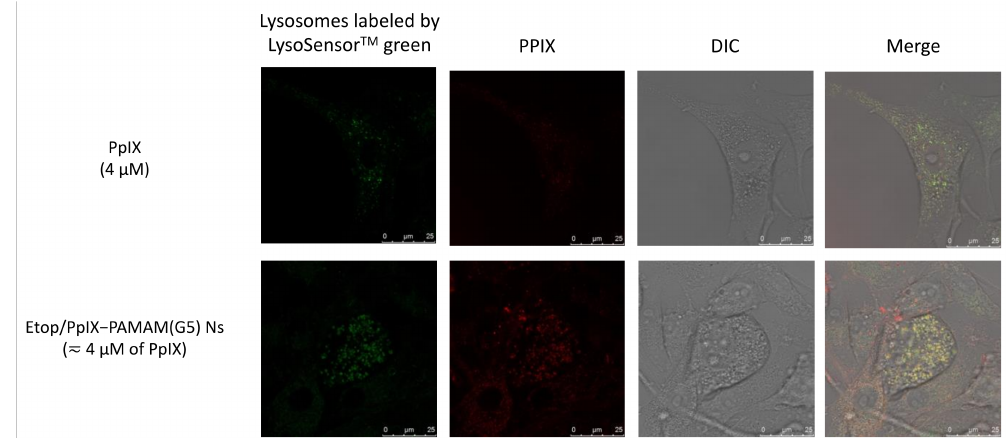
Figure 9. U87-MG cells incubated with PpIX or Etop/PpIX-PAMAM(G5) Ns for 1 h and then with LysoSensor™ Green for 30 min were imaged by confocal microscopy; fluorescence images were taken with the excitation and emission wavelength for PpIX (409 nm/570 nm) and LysoSensor™ Green (488 nm/561 nm). DIC microscopy images were taken for image fusion. PpIX fluoresces red while lysosomes labeled by LysoSensor™ Green fluoresces green. PpIX, Etop/PpIX-PAMAM(G5) Ns, and LysoSensor™ Green appeared to co-localize on the merge image, which indicated that these agents were in the endo-lysosomal compartment. (DIC—differential interference contrast, Etop—etoposide, PAMAM(G5) Ns—generation-5 polyamidoamine dendrimer nanosphere, PpIX—protoporphyrin IX). The scale bars = 25 µ